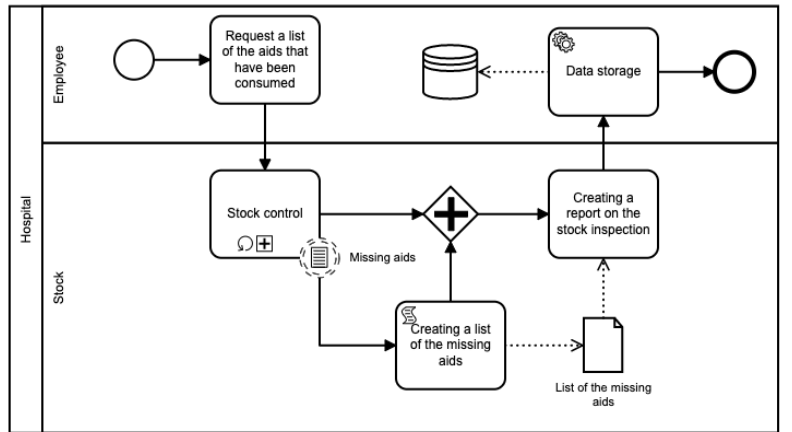
Figure 12. Collection of consumed